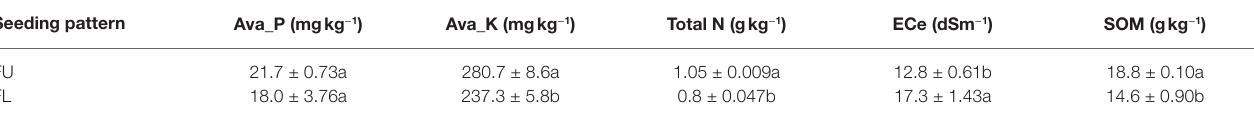
TABLE 2 | Soil properties (0–15 cm depth) under two seeding pattern treatments in April 2020. Seeding